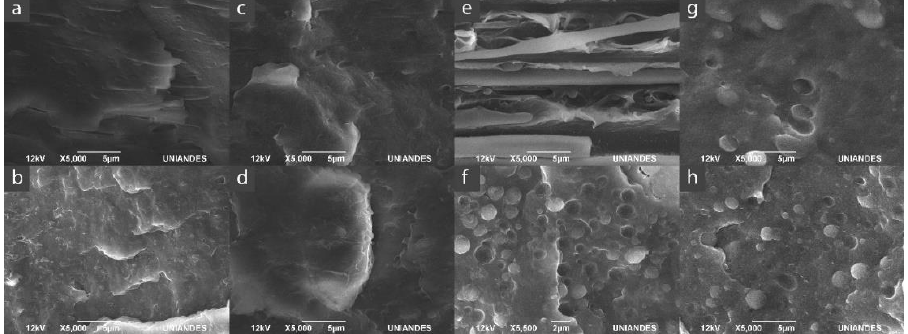
Figure 1. SEM images for the polymeric blends and the nanocomposites. ( a ) PP/EVA12, ( b ) PP/EVA12/MMT, ( c ) PP/EVA28, ( d ) PP/EVA28/MMT, ( e ) PP/EVOH38, ( f ) PP/EVOH38/MMT, ( g ) ( d ) PP/EVA28/MMT, ( e ) PP/EVOH38, ( f ) PP/EVOH38/MMT, ( g ) PP/EVOH44 and ( h ) PP/EVOH44 and ( h ) PP/EVOH44/MMT.